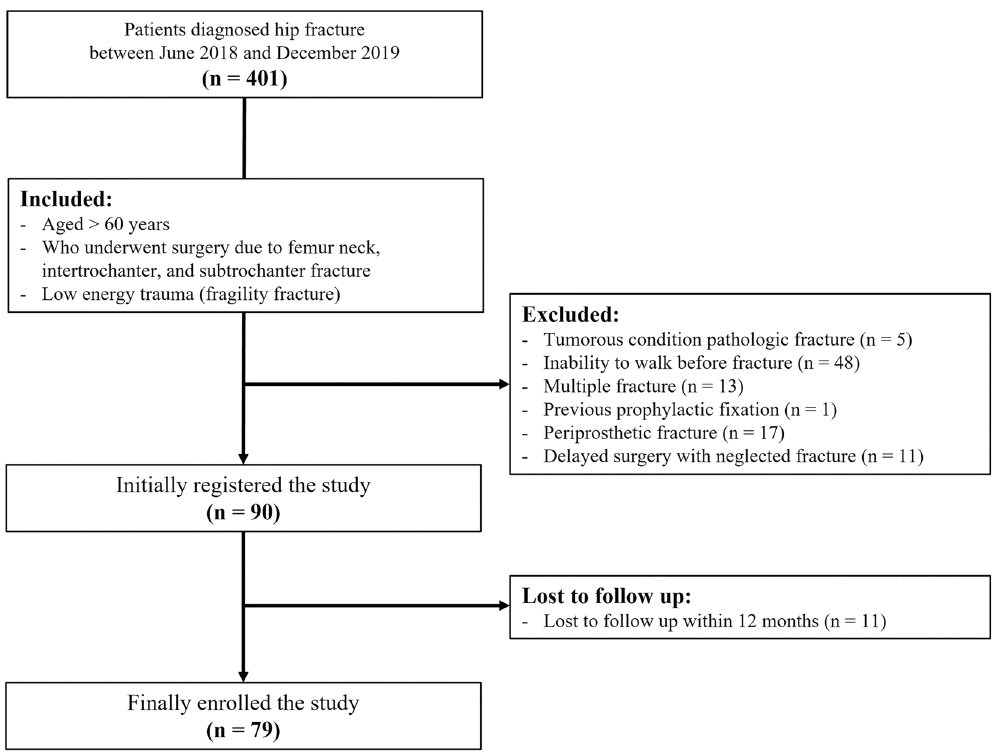
Figure 1. Flow diagram of patient